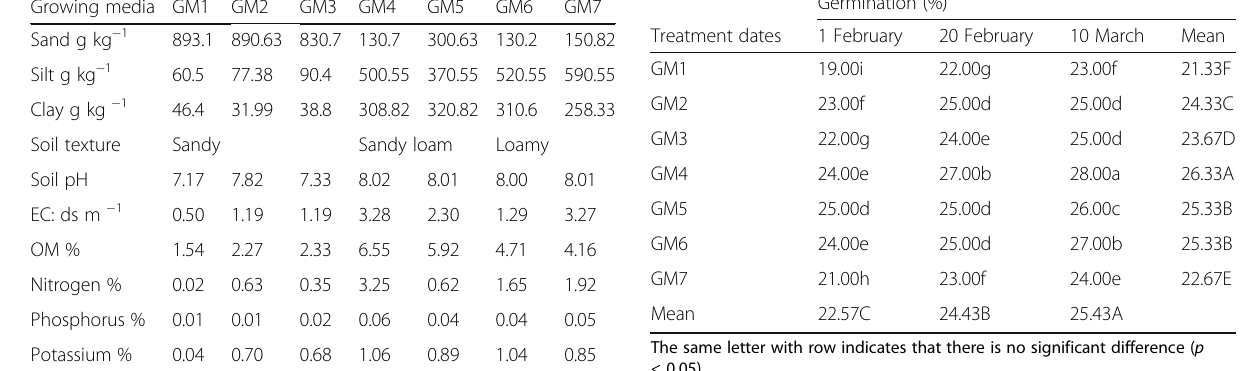
Table 1 Physical and chemical properties of the growing media Growing media GM1 GM2